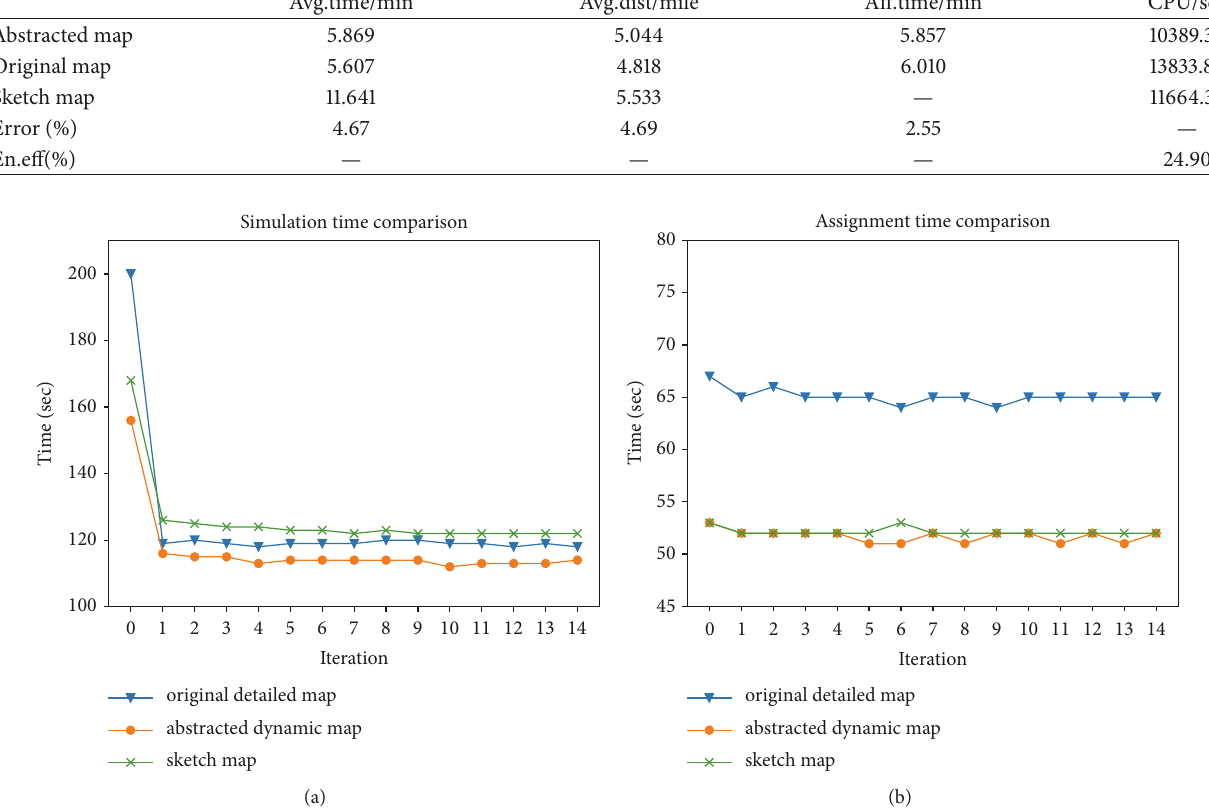
Figure 12: CPU times of simulation and assignment over iterations in SBDTA. A comparison between the original detailed map scenario, abstracted dynamic map scenario, and sketch map